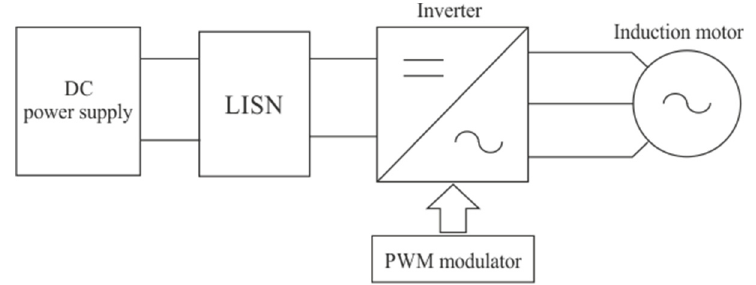
Figure 3. Block scheme of the experimental arrangement.